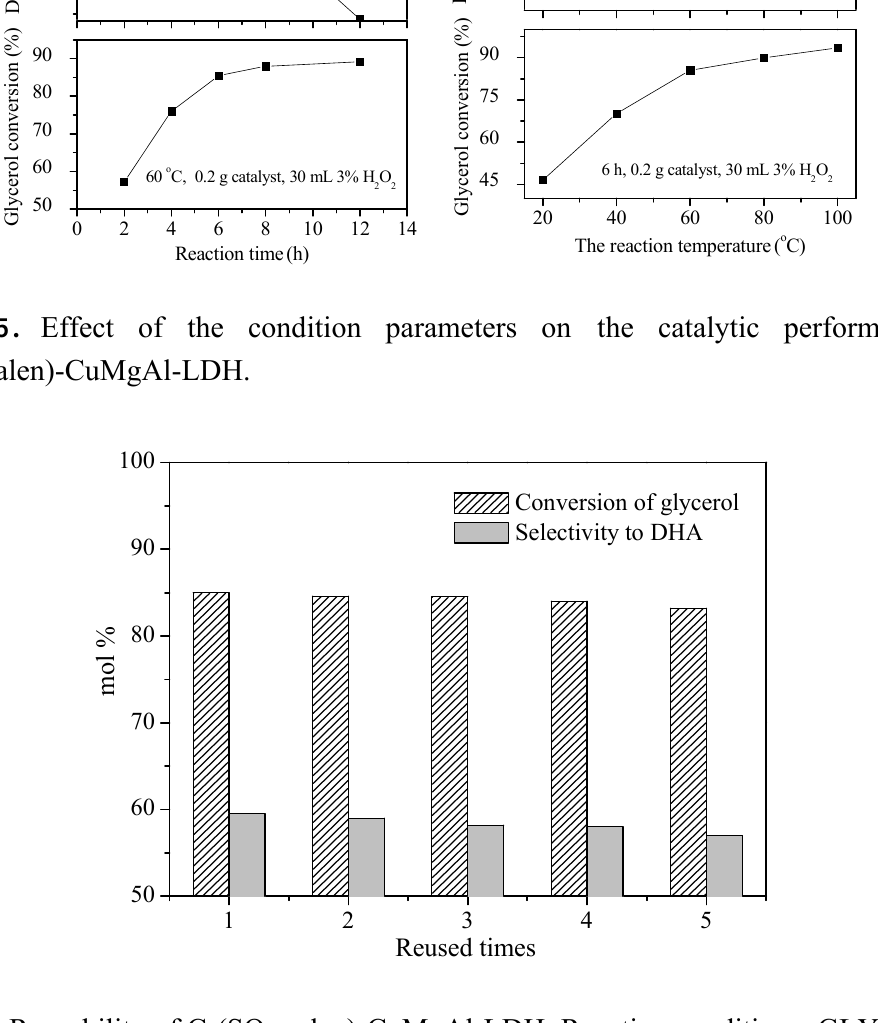
Figure 6. Reusability of Cr(SO 3 -salen)-CuMgAl-LDH. Reaction conditions: GLY (50 mL, 0.2 mol·L − 1 ), 3% H 2 O 2 30 mL, catalyst 0.2 g, 60 °C, 6